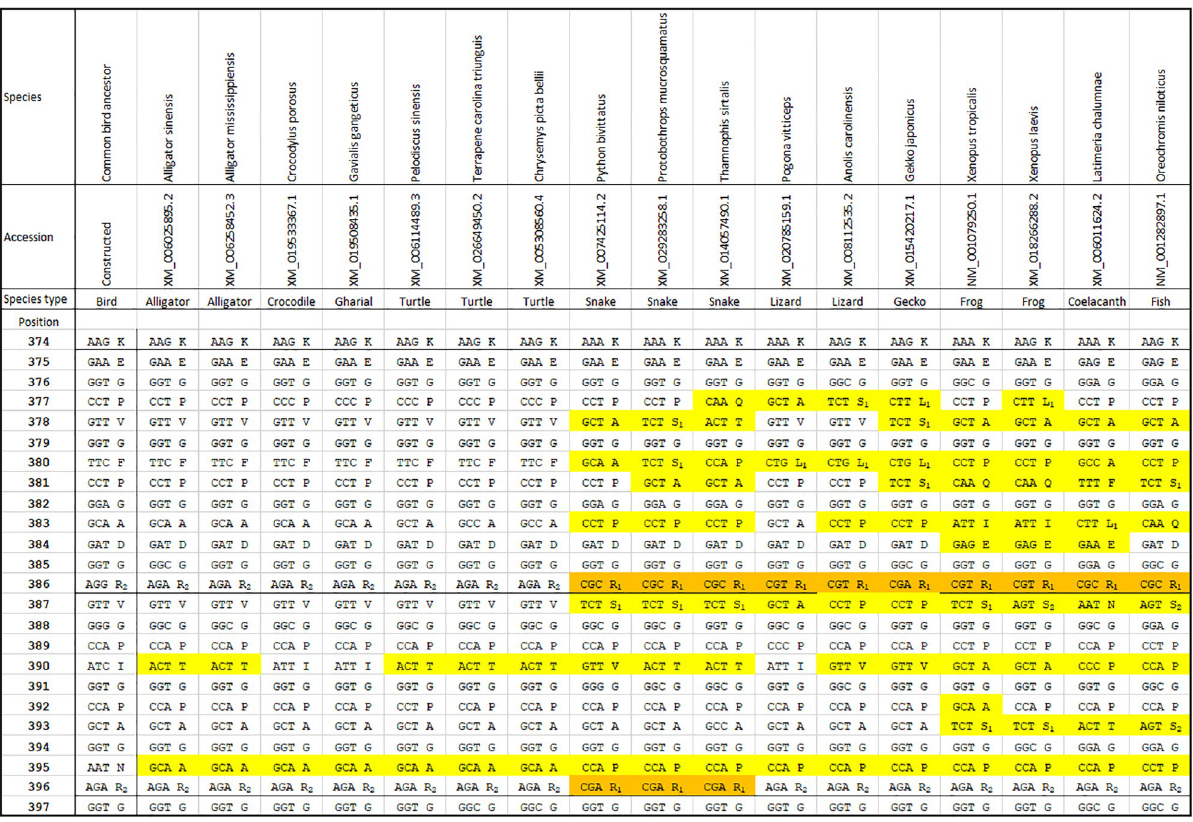
Fig 3. Species comparison of positions 374–397 of the collagen 1 α 2 GXY domain. The left sequence is from the constructed common ancestor of birds and the other sequences are from several reptile, frog and fish species, for comparison. On the left of each cell the codon is mentioned and on the right of each cell the codon group [21], which corresponds to amino acid (without the subscript). Compared to the common ancestor of birds, yellow cells correspond to amino acid differences and orange cells to codon group differences that do not lead to amino acid differences. Tryptic cleavage sites are presented as thick lines between